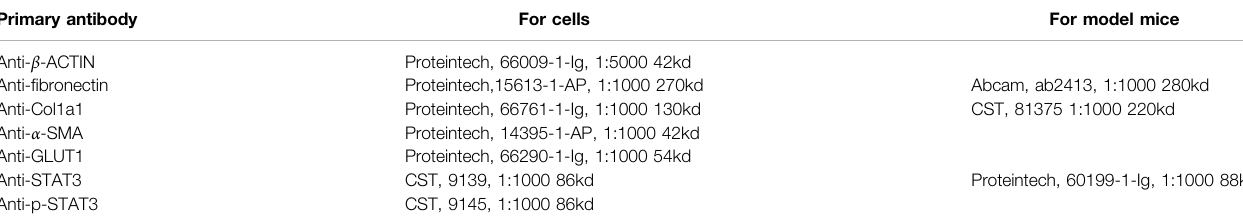
TABLE 1 | Information of the primary antibody used for cells and model mice. Primary antibody For